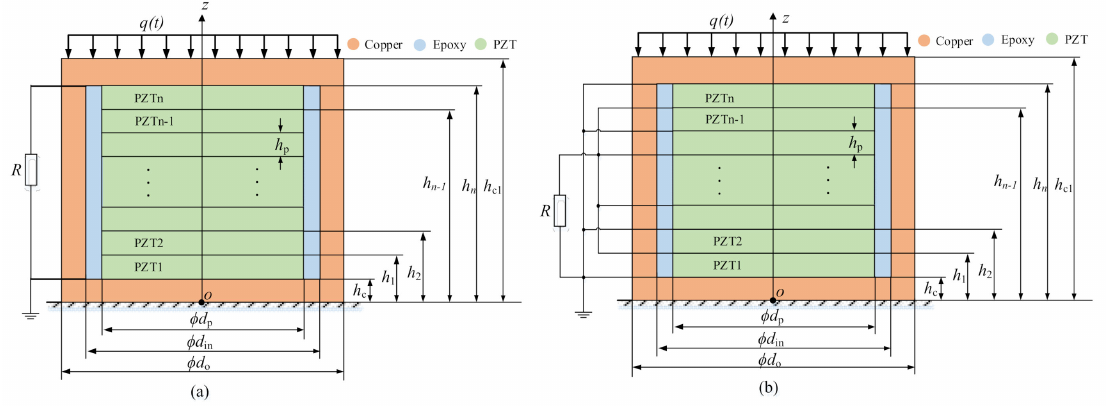
Figure 5. The simplified models of PiSSA sensors: ( a ) wafers in series; and ( b ) wafers in